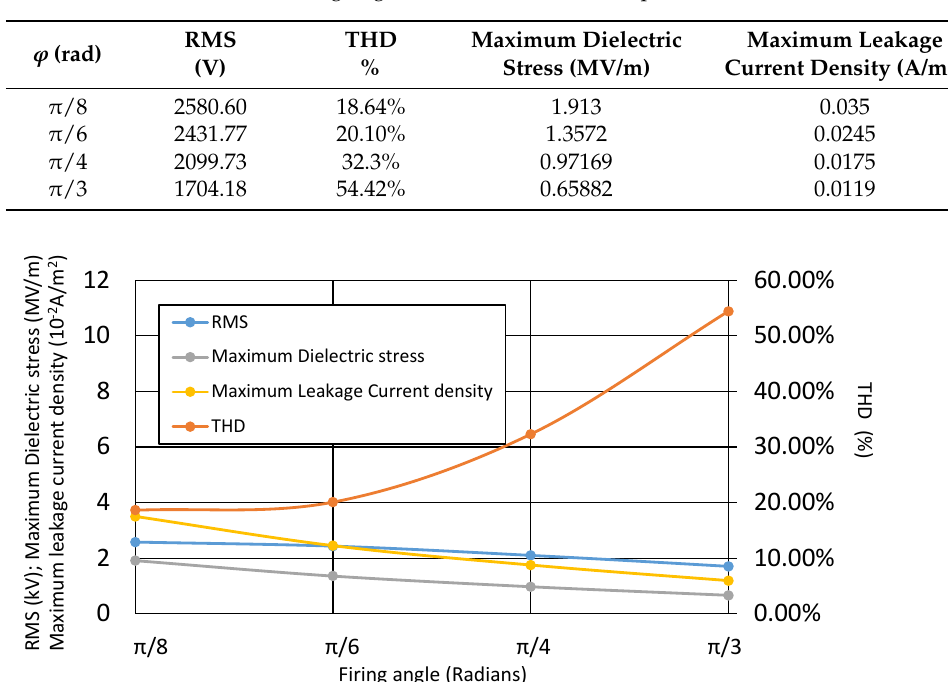
Table 5. Effect of increase in firing angles for 3-level inverter output.